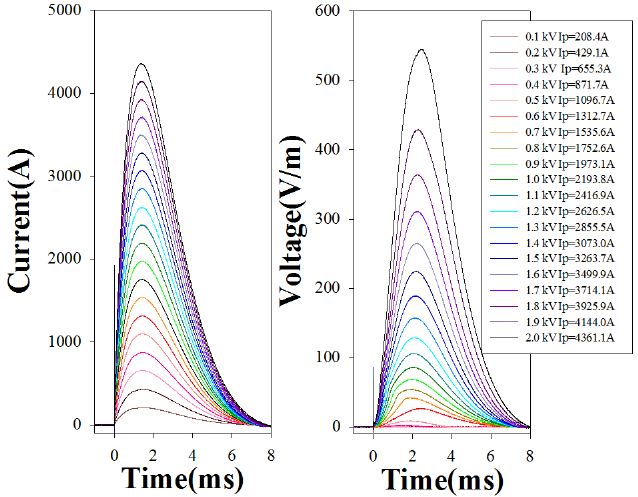
Figure 5. Transient impulse current and voltage waveform of sample 4.